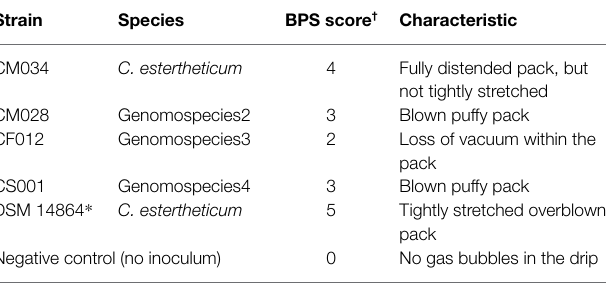
TABLE 1 | Blown pack spoilage (BPS) potential of selected Clostridium estertheticum complex (CEC)